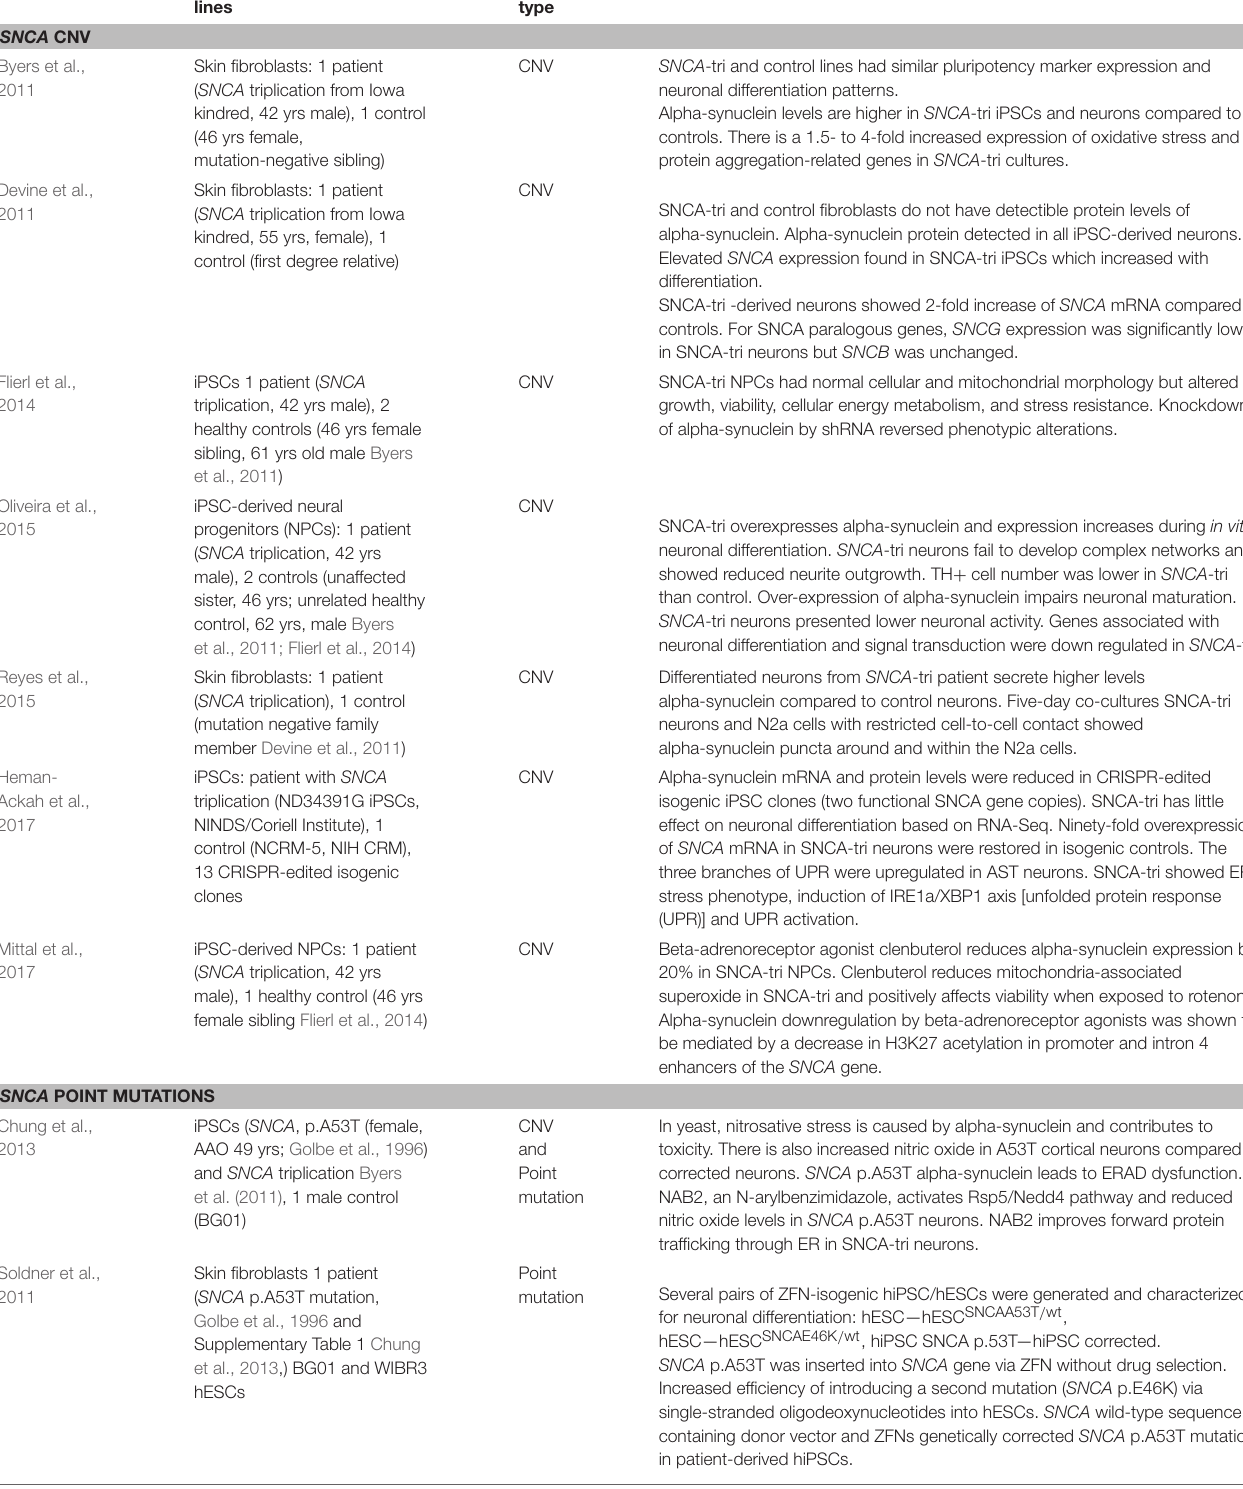
TABLE 1 | Human iPSC models with mutations and genetic variants in SNCA gene elicit specific molecular and cellular